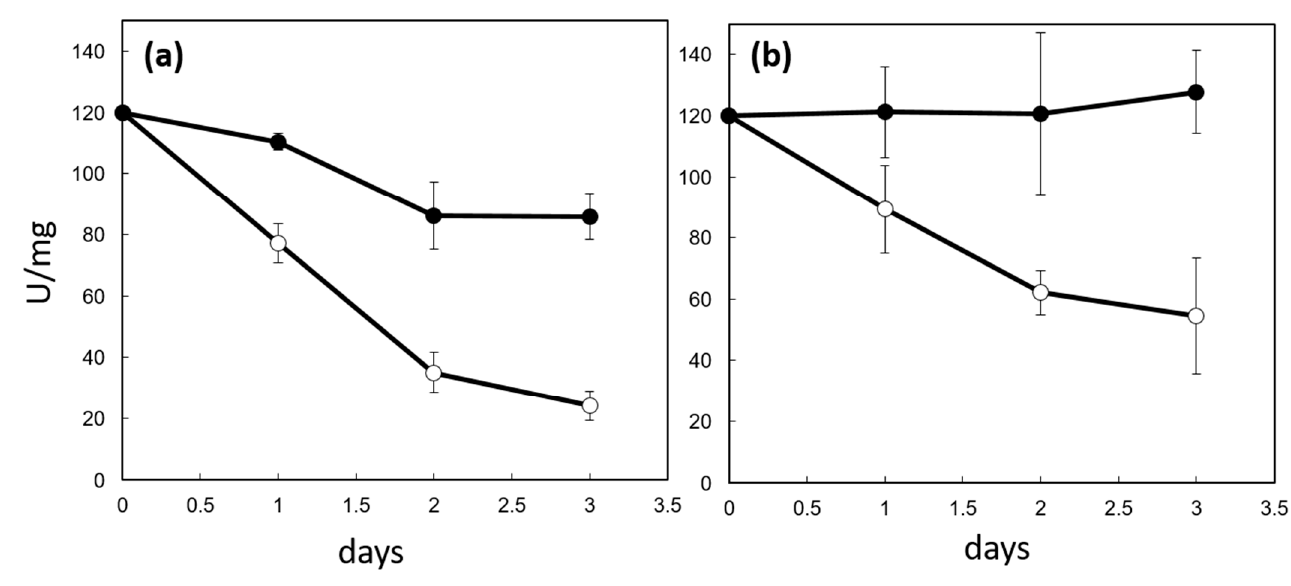
Figure 4. Effects of CP12 on PRK activity. Mixtures (1:1 molar ratio) of CP12 and PRK (black circle) and PRK (white circle) were incubated at 4 °C and PRK activity was measured at four time points ( a ). The same samples were also reduced with 20 mM DTT for 1 h prior activity measurement ( b ). The PRK activity is reported as units per mg of PRK. One unit (U) is the amount of enzyme that catalyzes the reaction of one µmol of substrate per minute.